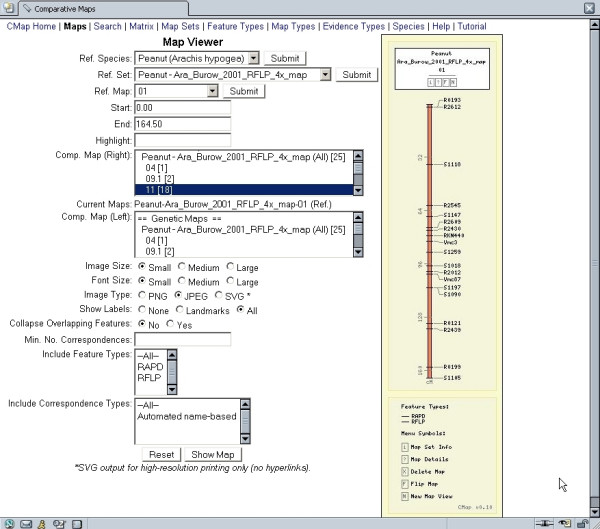
Sample linkage group display with associated menus. Linkage group 1 from the tetraploid map is displayed at right. At left can be seen menus for selection of map sets and maps within a set, and choices to limit the types of markers that are displayed.